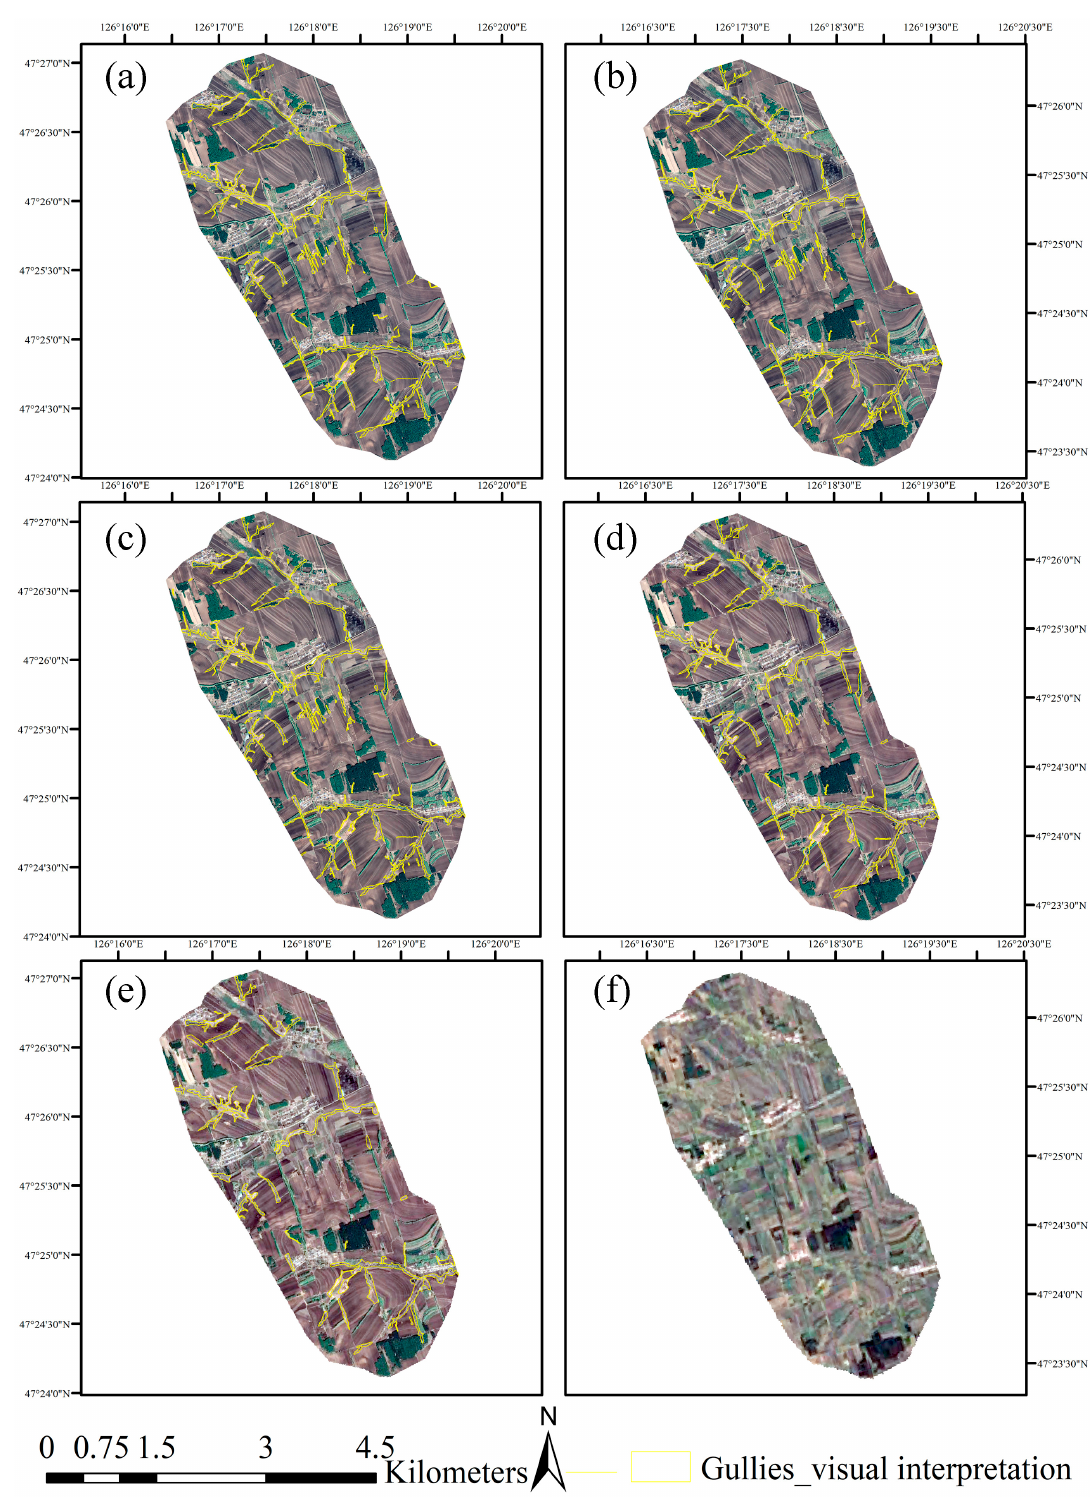
Figure 2. Gullies by visual interpretation. ( a – f ) Gullies visually interpreted using GE images with a resolution of 0.51, 1.02, 2.04, 4.08 and 8.16 m, respectively.